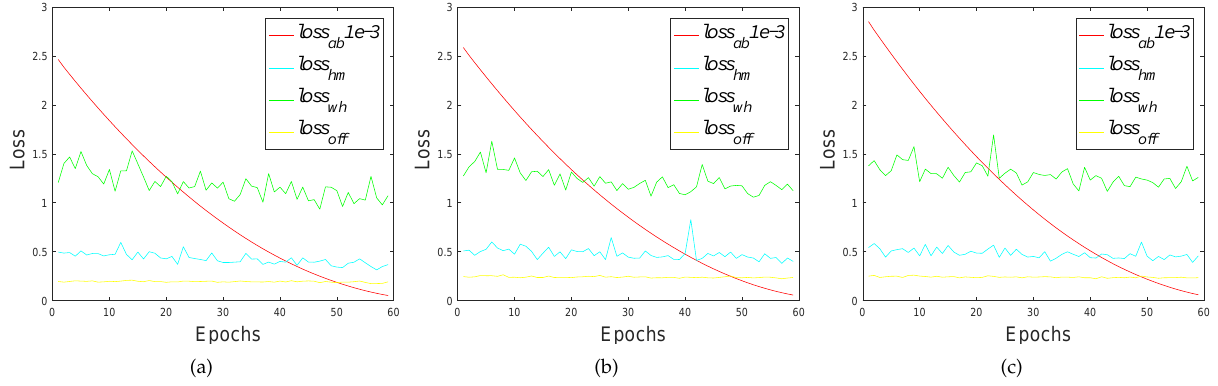
Figure 7. The absorbing training results when selecting filters in ascending, descending, and random order of learning difficulty: ( a ) Ascending order; ( b ) Random order; and ( c ) Descending